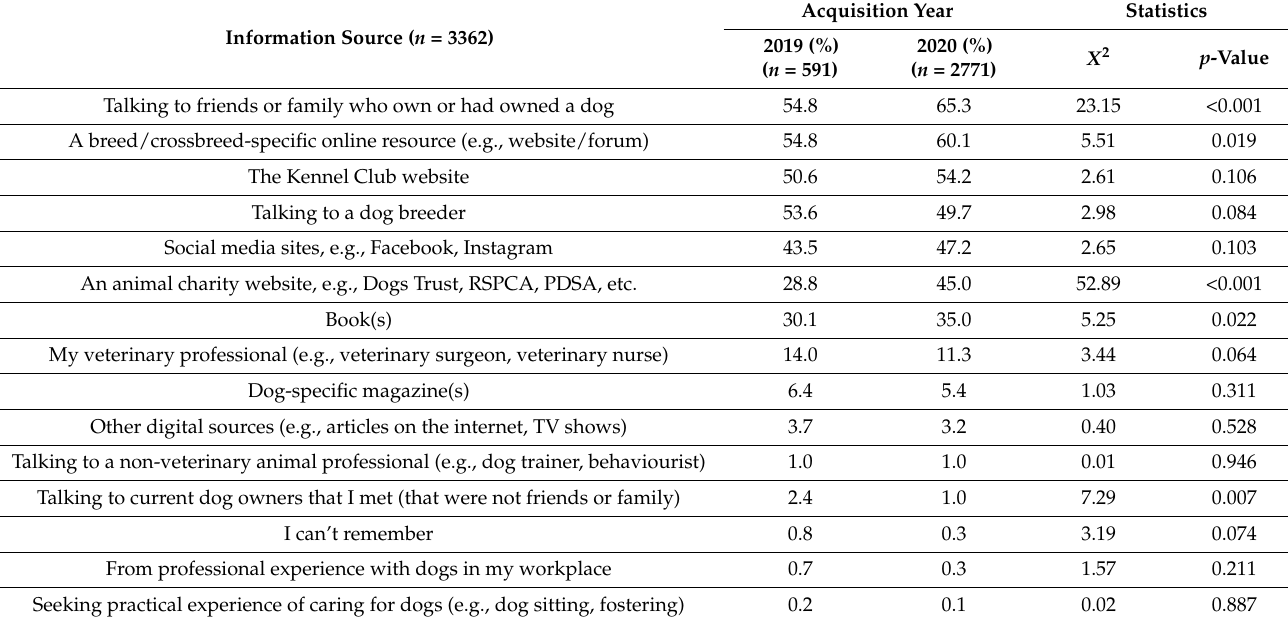
Table 6. Sources of information used when researching dog ownership and/or which breed/crossbreed to purchase prior to purchasing a puppy, with comparisons between 2019 puppy ( n = 591) and Pandemic Puppy owners ( n = 2771) in the UK.